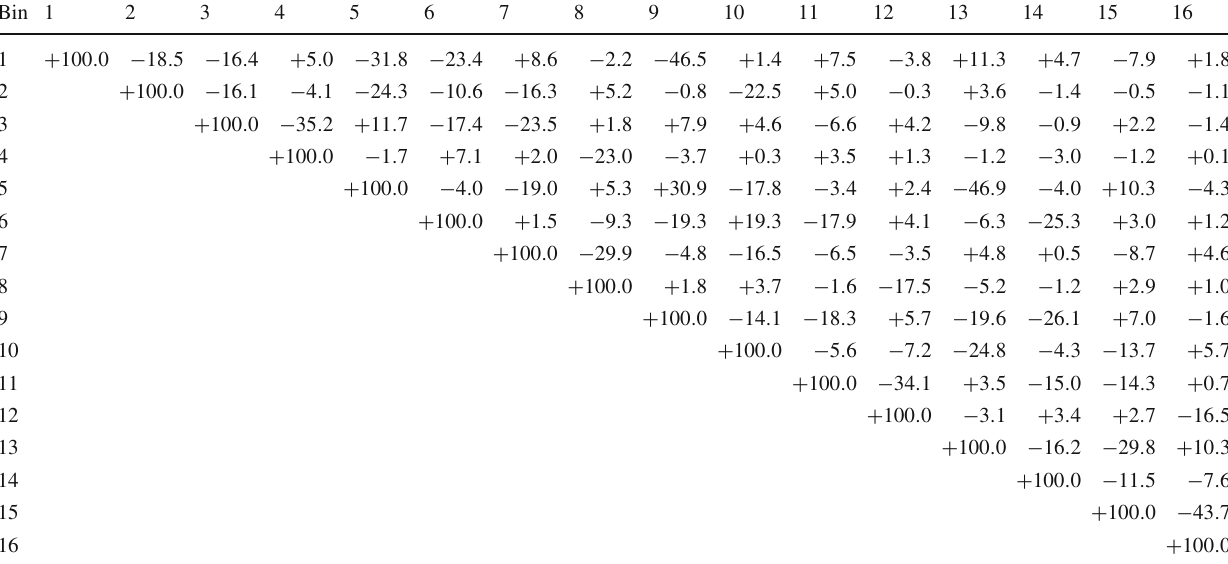
Table 6 The correlation matrix of statistical uncertainties for the normalized tt double-differential cross sections as a function of y ( t ) and p T ( t ) . The values are expressed as percentages. For bin indices see Table 5 Bin